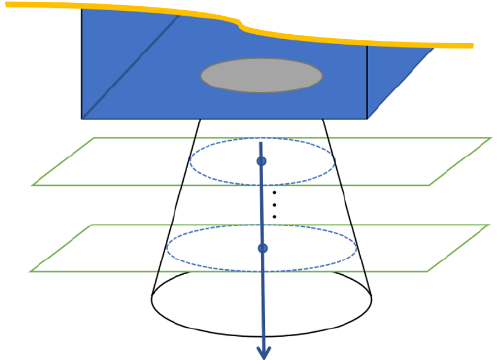
Figure 10. Axis fitting by the intersecting